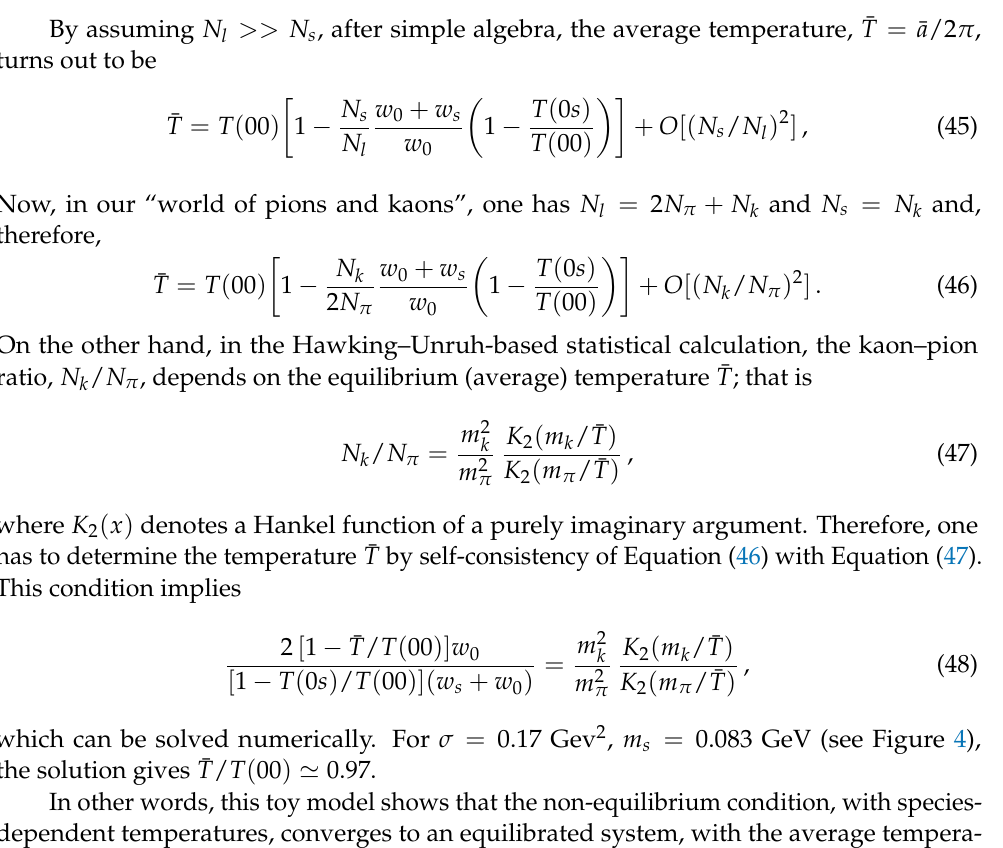
Figure 5. Left: Hadron production alla Unruh by a sequence of independent single string breakings. Right: Hadron production due to the overlap of different color event horizons for large parton